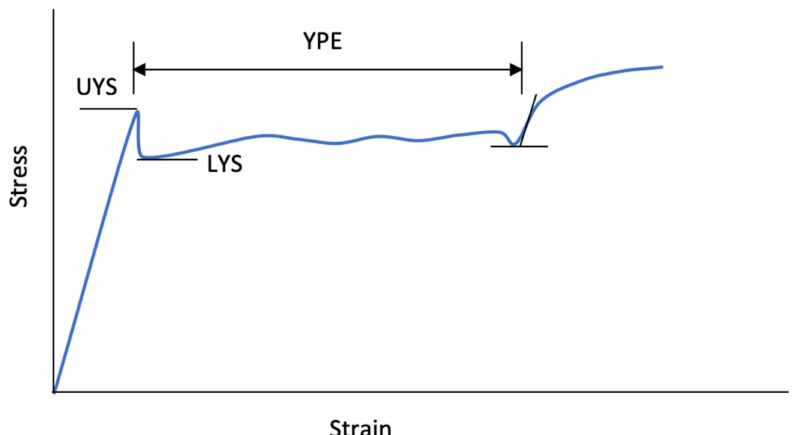
Figure 1. Stress–strain diagram showing Yield Point Elongation (YPE) and Upper (UYS) and Lower (LYS) Yield Strengths [10].